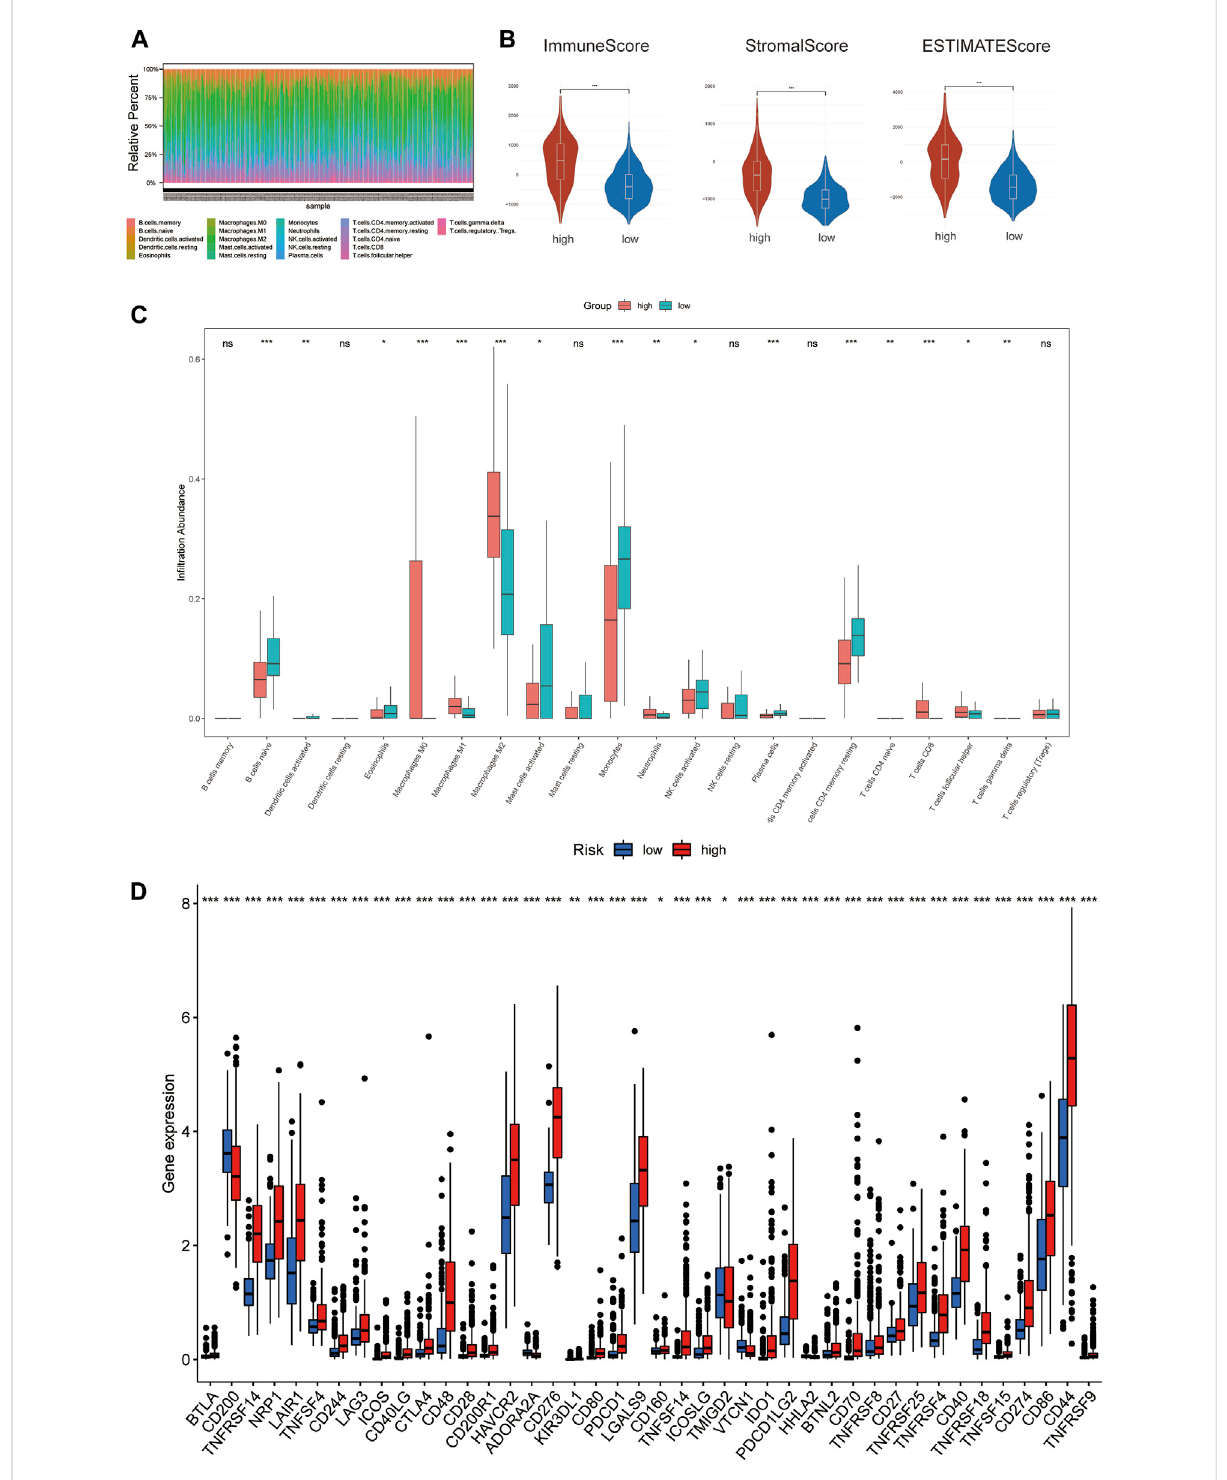
FIGURE 7 The degree of immune in fi ltration in glioma patients. (A) Immune cell distribution in high-risk and low-risk groups in the 3-FRLs model. (B) Stroma,immune,andESTIMATEscoresinthehigh-riskandlowriskgroupsingliomapatients. (C) Boxplotofcomparisonofimmunecellsinhigh-risk and low-risk groups. (D) Boxplots comparing immune checkpoint genes in high- risk and low-risk